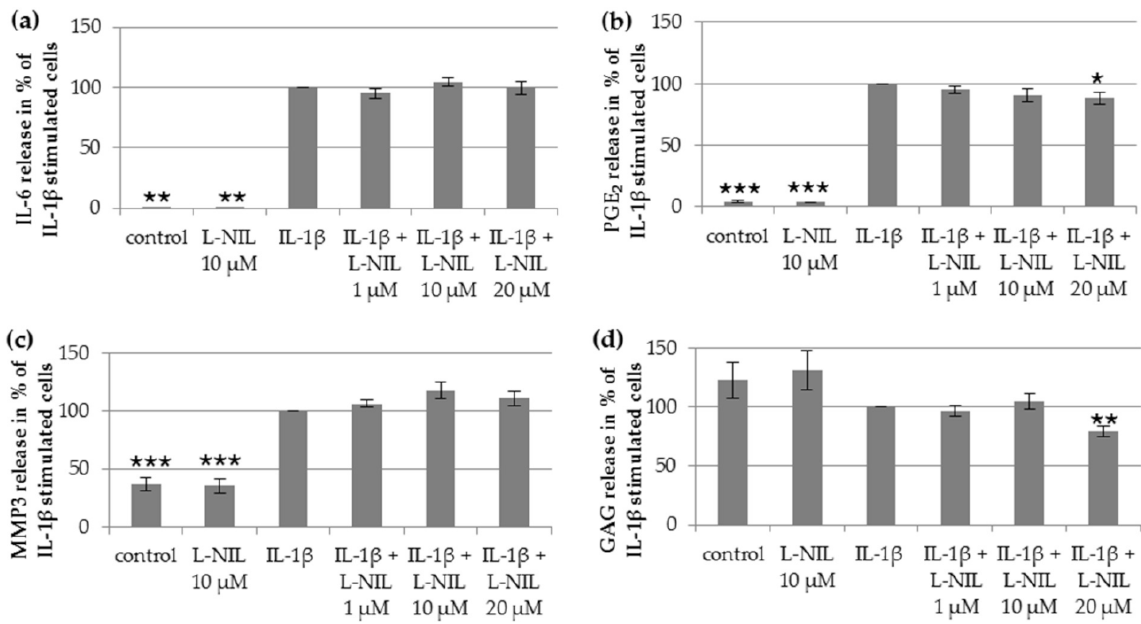
Figure 3. Impact of L-NIL on the IL-1 β -induced release of ( a ) IL-6 ( n = 6), ( b ) PGE 2 ( n = 5), ( c ) MMP3 ( n = 7), and ( d ) the production of GAG ( n = 6). Values are reported as percentage ± SD normalized to IL-1 β -stimulated cells. Statistical differences vs. IL-1 β -stimulated cells, repeated-measures ANOVA with Post Hoc test; *** p < 0.005, ** p < 0.01 and * p <